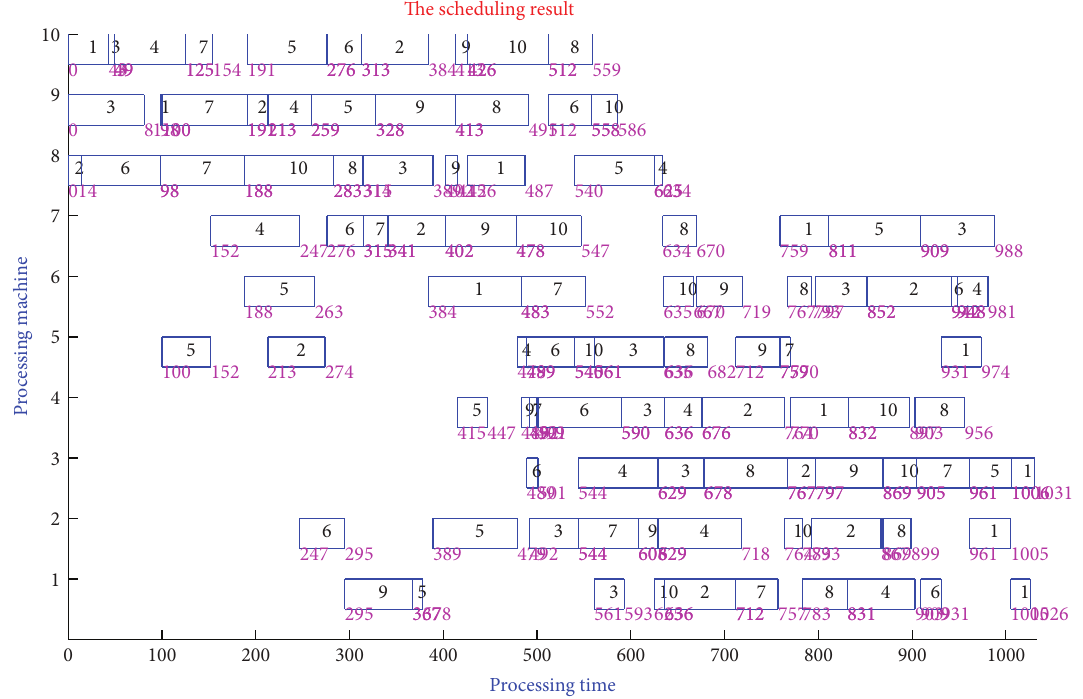
Figure 8: GANT graph of 6 ∗ 6 JSSP generated by